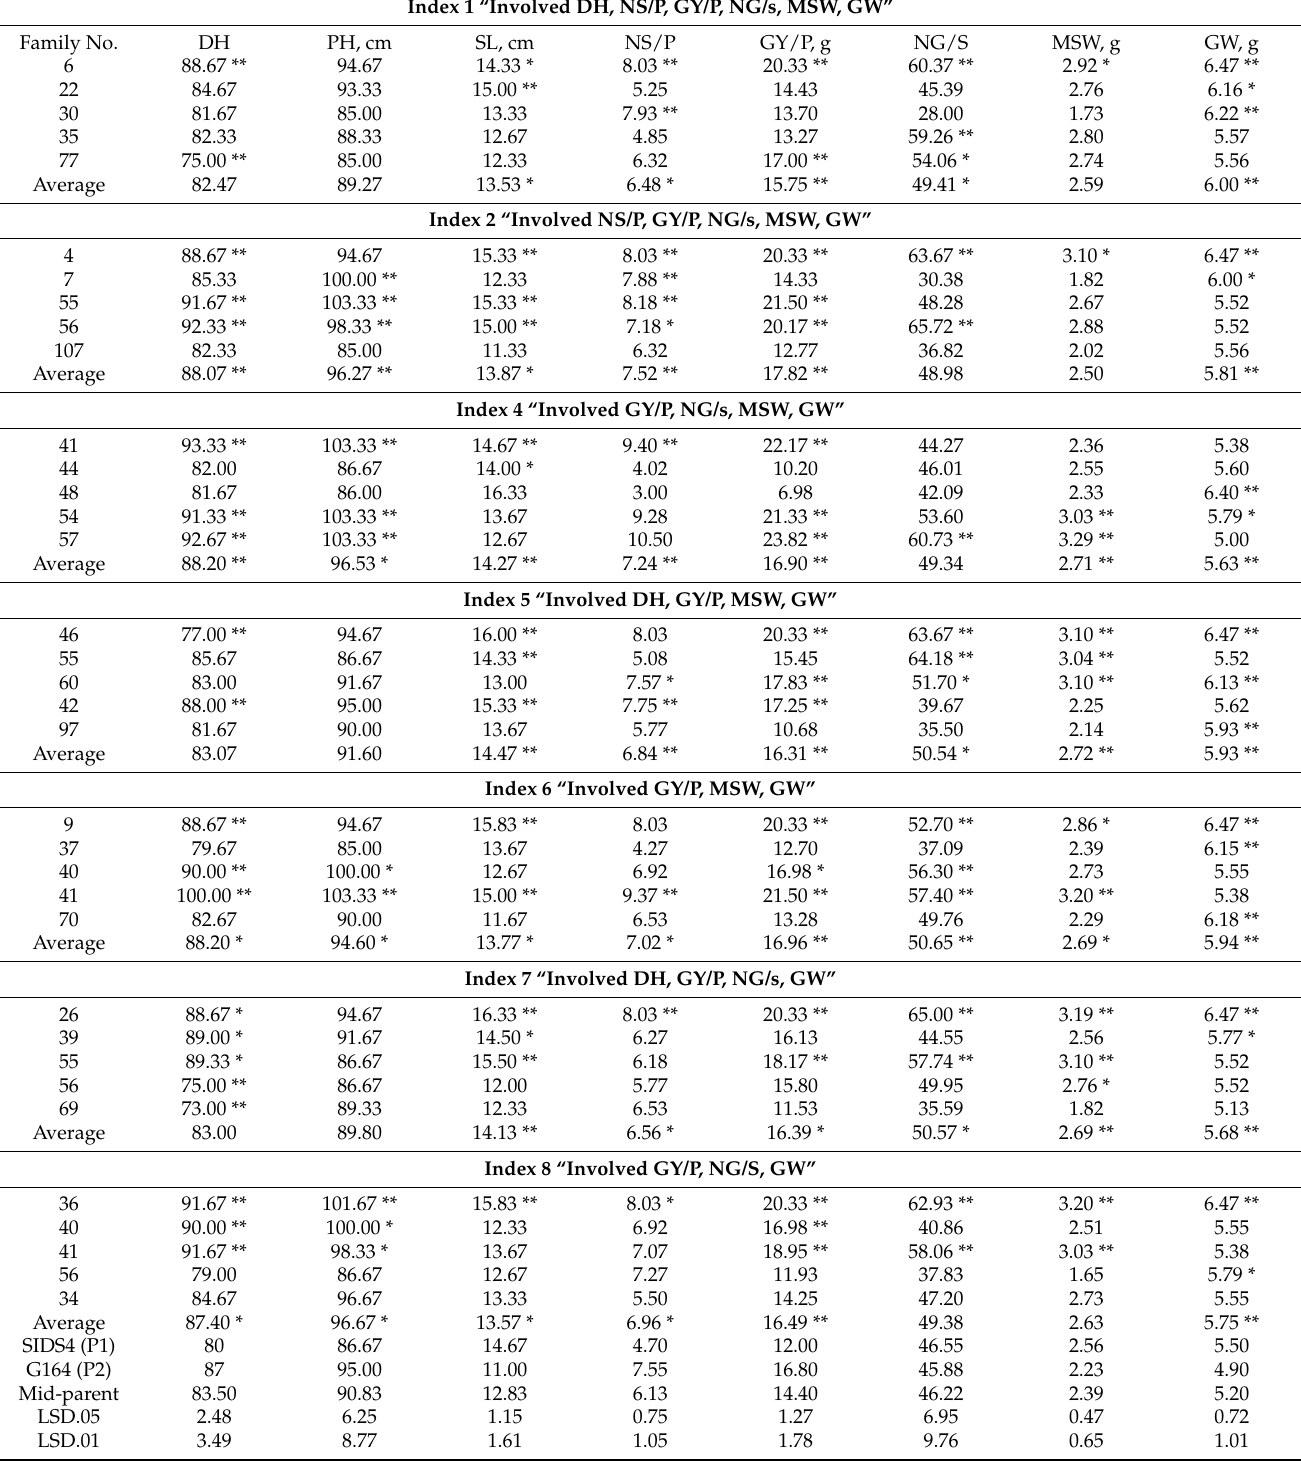
Table 5. Means of the parents and the selected families after the second cycle of